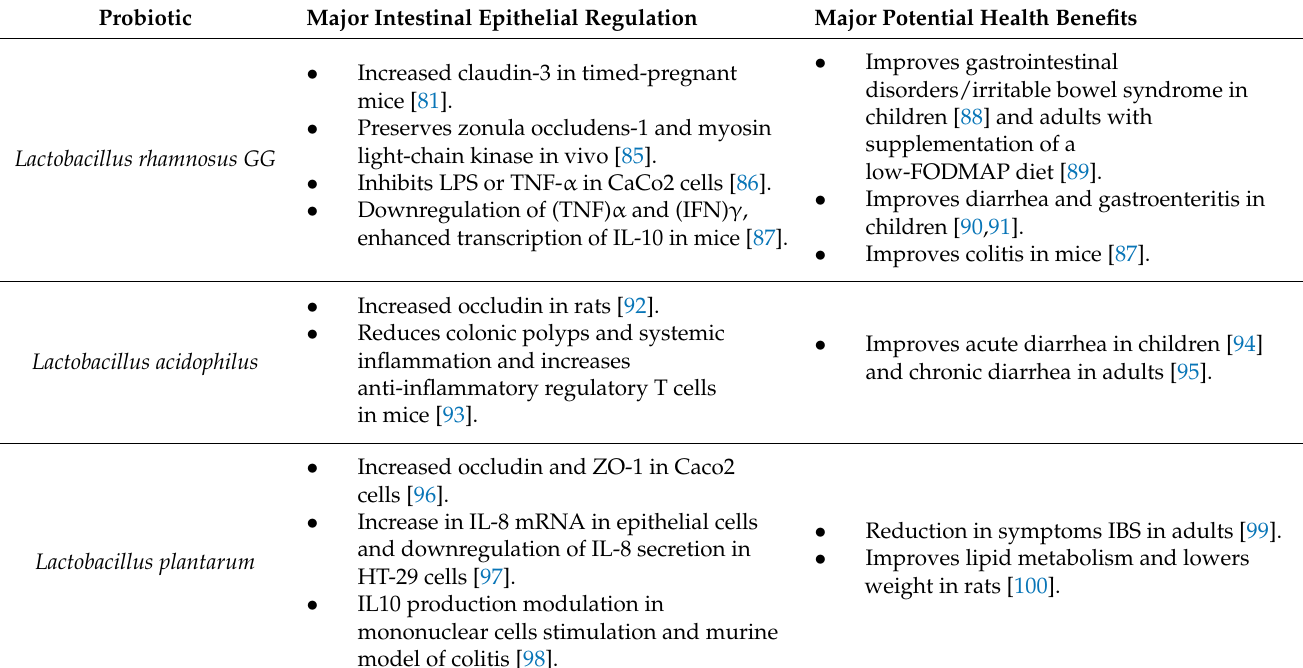
Table 1. Major probiotics that help leaky